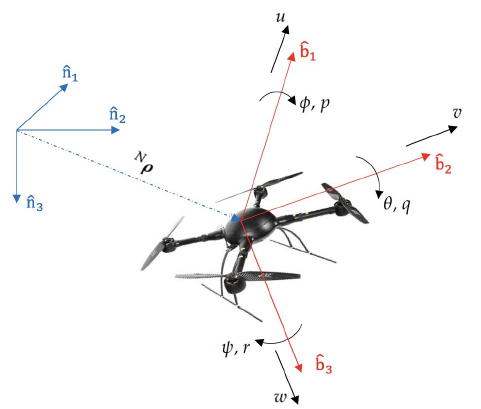
Figure 1. Definitions of the reference frames and the state variables of the